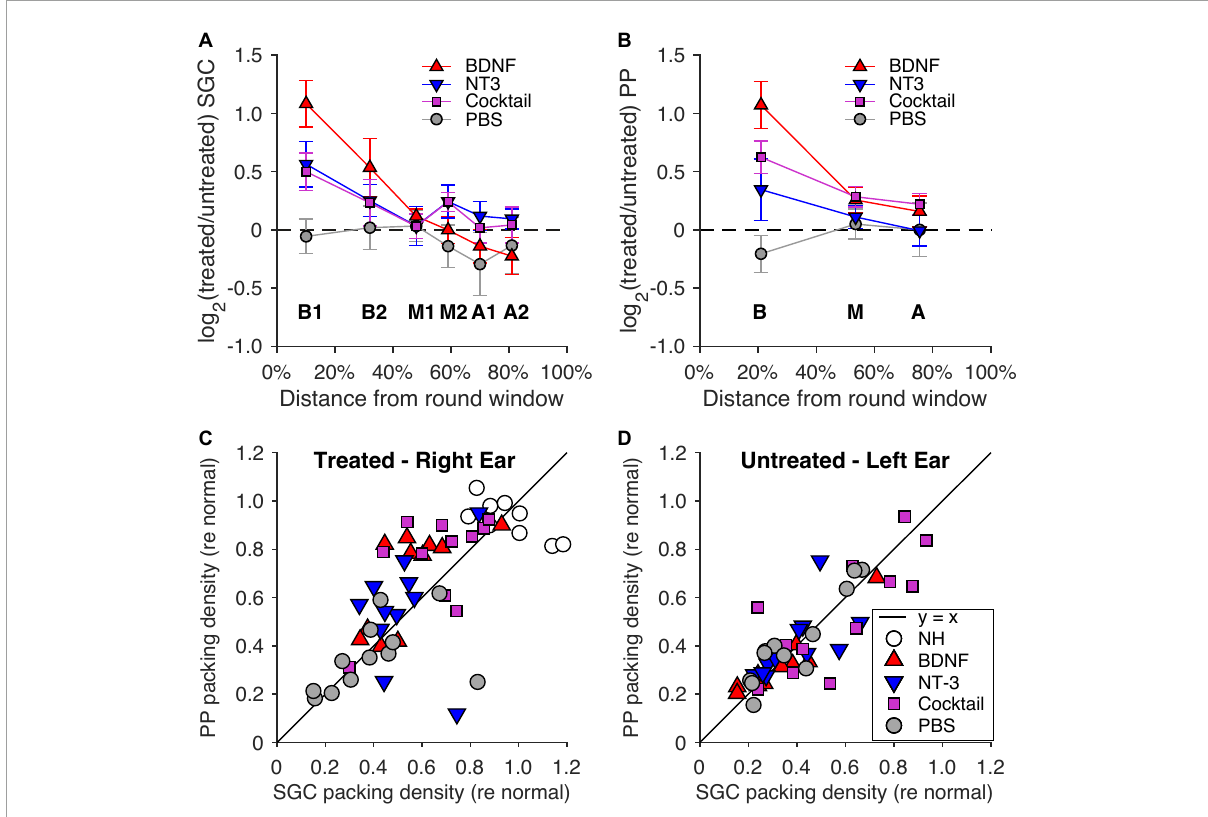
FIGURE4 Log 2 transformed ratio between the right (treated) and left (untreated) ears for (A) SGC packing density and (B) PP packing density as a function of cochlear location relative to the round window, with 0% as the round window and 100% as the helicotrema. The dashed line indicates equal packing densities between the treated and untreated ears. PBS, n = 12 ( n = 11 for location A in B); BDNF, n = 12; NT-3, n = 11 ( n = 10 for location B1 in A ); Cocktail, n = 12 ( n = 10 for location B1 in A ; n = 11 for location A in B ). Error bars represent SEM. Normalized basal packing densities of PPs are shown as a function of normalized SGC packing density for (C) the right (treated) ear and (D) the left (untreated) ear. The black y = x line represents the 1:1 ratio of PP: SGC packing density.